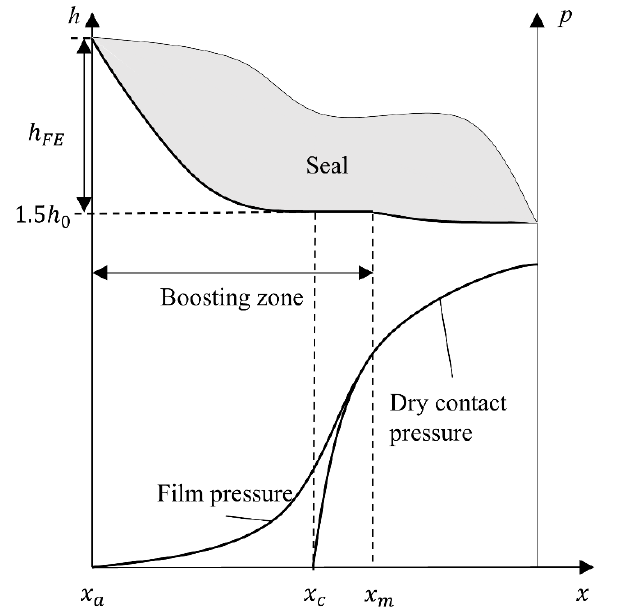
Figure 3. Film pressures vs. contact pressures and assumption for the film profile in the boosting zone.